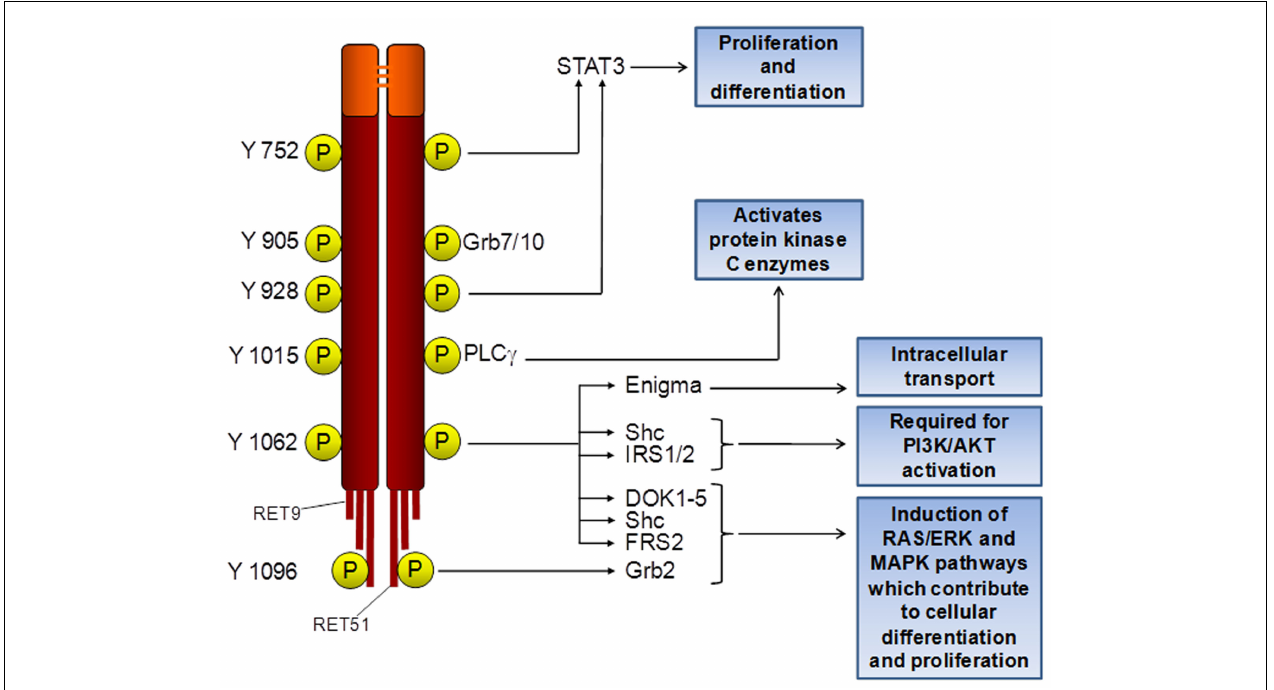
FIGURE 8 | Signal transduction pathways regulated by RET/PTCs. Tyrosine residues (Y) are numbered according to integral RET amino acid sequence. RET9 and RET51 represent splicing variants of RET C-terminal tail.